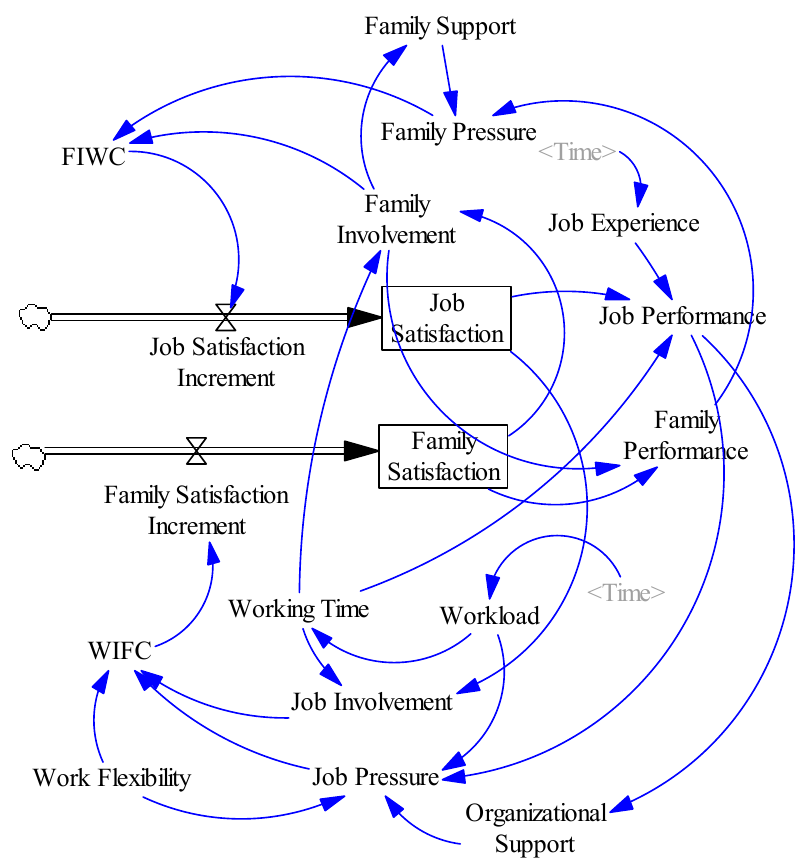
Figure 4. System flow diagram of construction industry employee WFC evolution. The diagram is constructed by the Vensim PLE software. There are two straight arrows in the system flow diagram which are called Rate. The Rate has a single arrowhead, indicating the direction that material can flow like a pipe with a valve. However, this is only a diagram, in a simulation model, the equation governs the direction that material can flow. In this system, the two rate variables flow to the two state variables as the material under the influence of FIWC and WIFC.